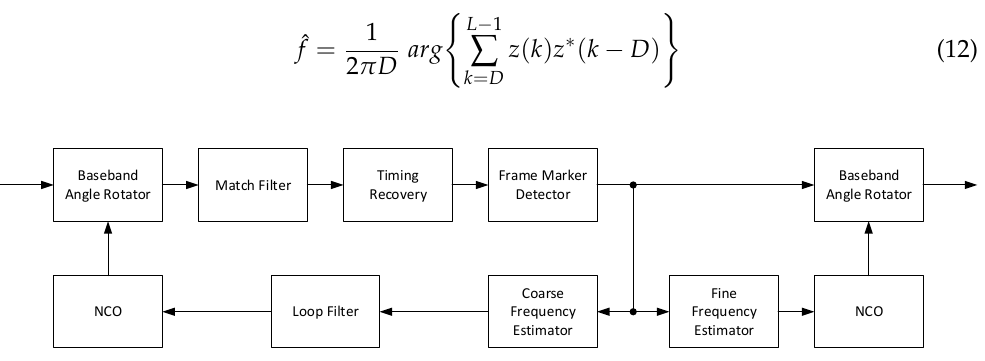
Figure 3. Coarse-fine frequency estimation